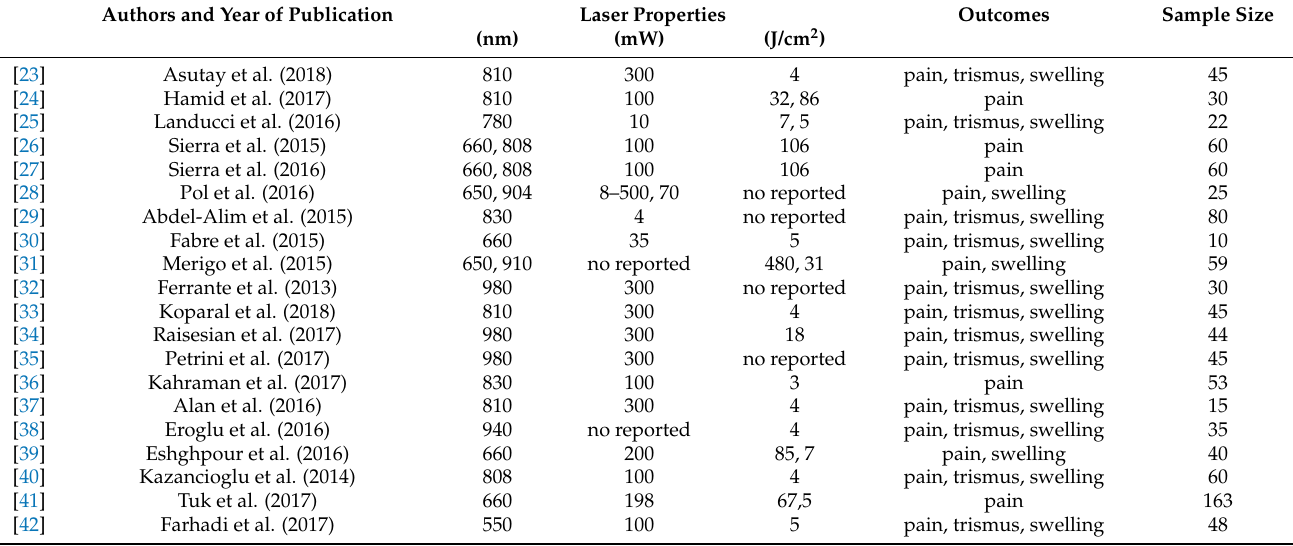
Table 1. Characteristics of the studies included.